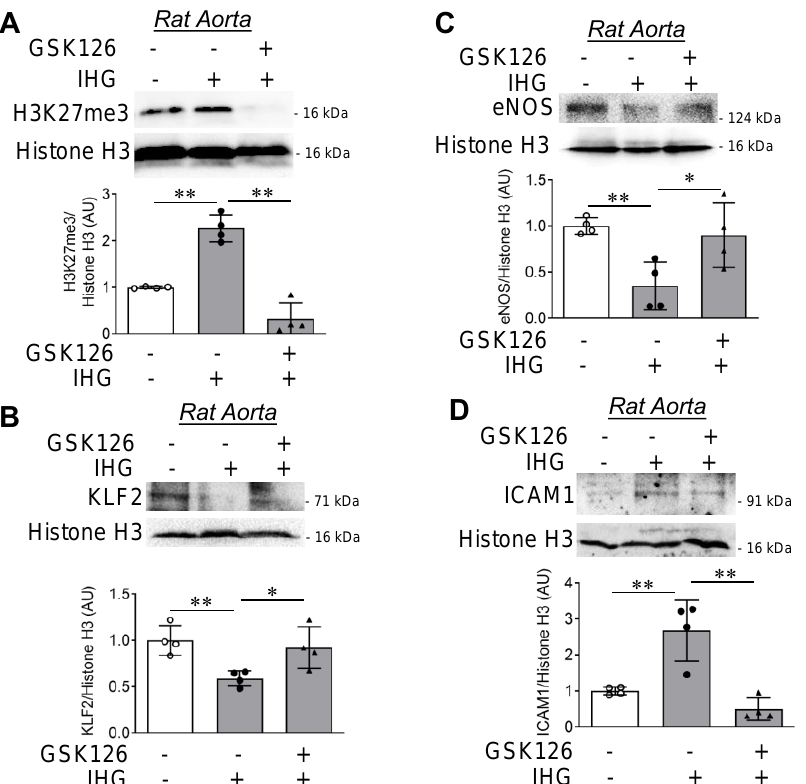
Figure 6. Inhibition of EZH2 in rat aortic rings exposed to intermittent hyperglycemia reduces H3K27me3 levels and blocks inflammatory signaling ex vivo. ( A – D ) Immunoblotting for H3K27me3 (( A ), n = 4), KLF2 (( B ), n = 4), eNOS (( C ), n = 4), and ICAM1 (( D ), n = 4) in rat aortic rings challenged with the EZH2 inhibitor GSK126 (10 μM for 72 h) in combination with intermittent high glucose. Tissues continuously exposed to normal glucose (5.5 mM) were considered as the non-intermittent high glucose treatment condition. All analyzed data were normalized to the control treatment condition. Values represent the mean ± SD. * p < 0.05 and ** p < 0.01 by unpaired t test.